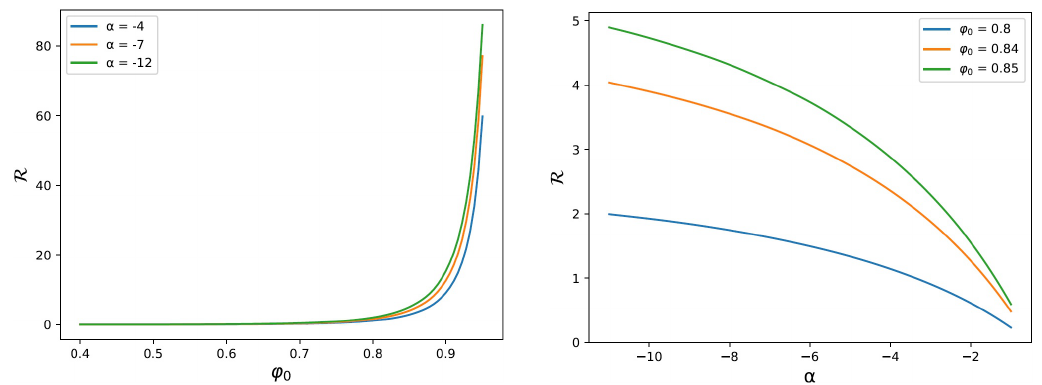
Figure 17 . Left: the dimensionless curvature R as a function of ϕ 0 for fixed values of α on the left, for Bolt end-point solutions. Right: the dimensionless curvature R as a function of α for fixed values of ϕ , for Bolt end-point 0